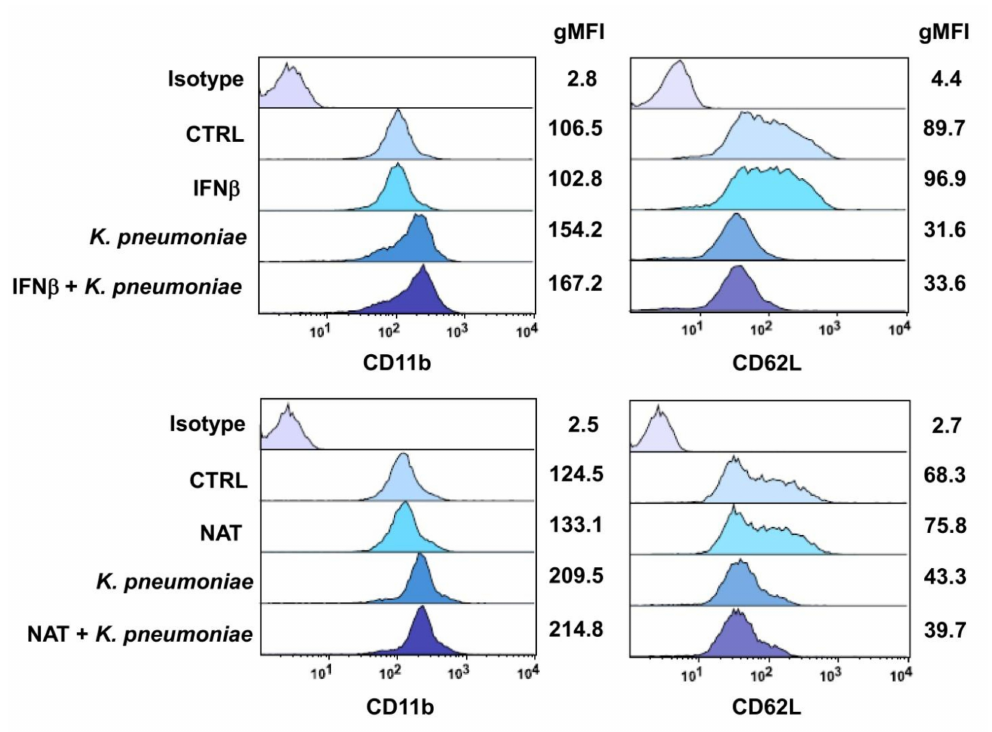
Figure 4. DMTs do not alter surface expression of CD11b and CD62L on resting and activated PMNs. Geometric mean fluorescence intensity (gMFI) of CD11b and CD62L on PMNs pretreated with one first-line (IFN β -1b) or second-line (NAT) drug following K. pneumoniae stimulation. The four panels illustrate representative phenotypes displayed by IFN β -PMNs (higher panels) or NAT-PMNs (lower panels), based on relative CD11b and CD62L expression levels. gMFI values relative to each marker and isotype control mAbs are shown on the right side of each